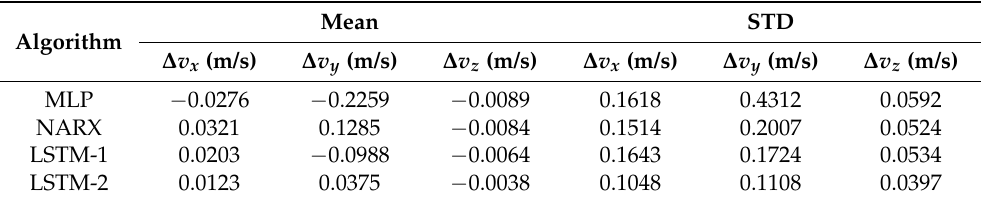
Table 4. The specific values of the error MEAN and STD of the four deep learning